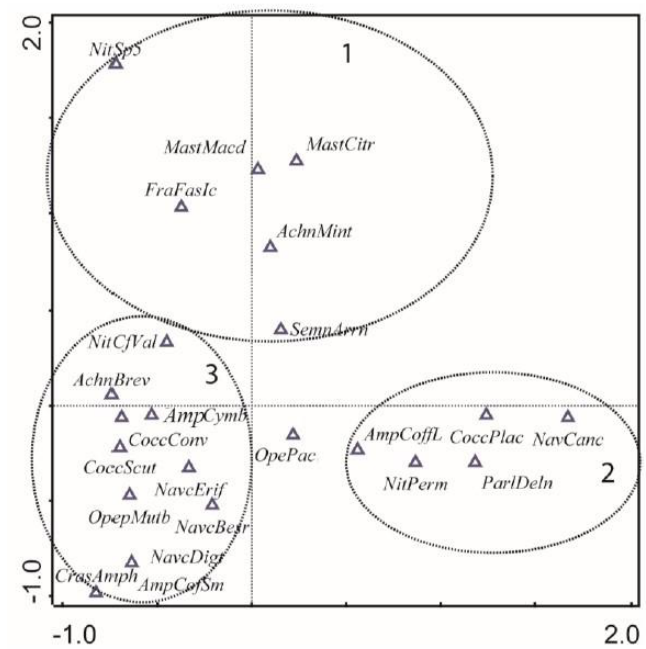
Figure 7. Detrended Correspondent Analysis (DCA) species biplot showing major patterns of diatom taxa distribution in the surface sediments of Khor al Beida mangroves. Species are shown as triangles, 3 assemblages are marked as ellipsoids and numbered. Only taxa with abundance above 1% are shown. For full diatom names please see Table A1.